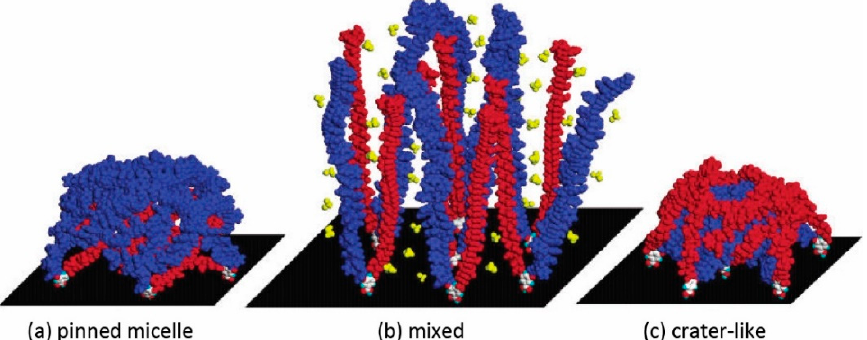
Figure 6. The proposed nanostructures of slightly asymmetrical Y-shaped polystyrene (PS) (blue)/poly(acrylic acid) (PAA) (red) mixed brush. ( a ) “pinned micelle” nanostructure after selective good solvent for PS (toluene) treatment, ( b ) swollen state after non-selective good solvent (mixed chloroform/methanol = 50/50) treatment, and ( c ) “crater” nanostructure after selective good